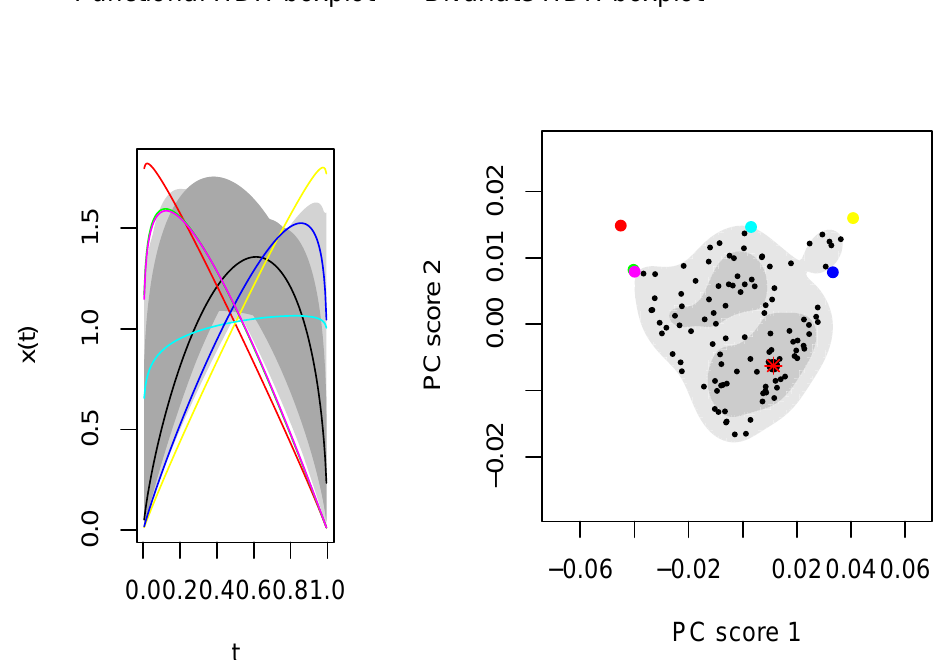
Figure A8. Upper row: synthetic data. Lower row, left column: functional HDR boxplot; right col- umn: bivariate HDR boxplot. Colored curves/points are outliers according to a coverage probability of 0.05 for the functional HDR boxplot. HDR boxplots computed with rainbow::fboxplot